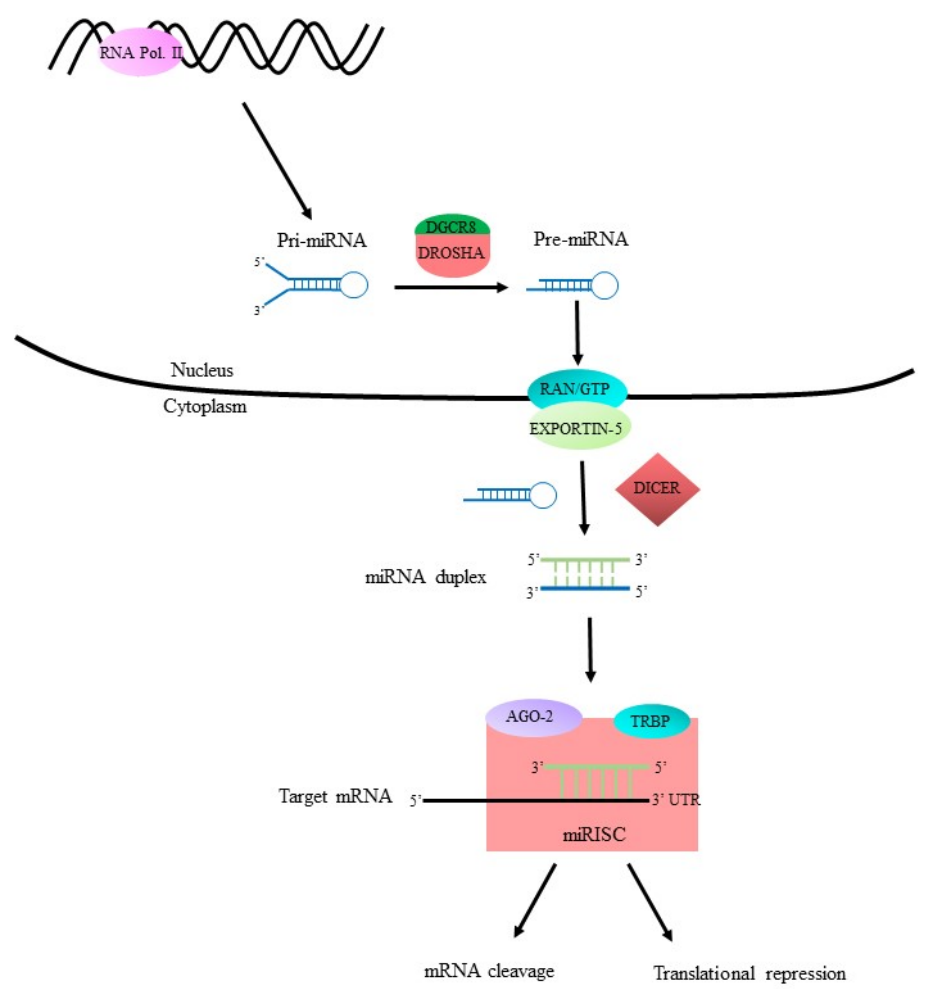
Figure 1. Canonical miRNA biogenesis pathway. RNA polymerase II transcribes DNA of interest into pri-miRNA containing ~80 nucleotides (nts). The Drosha/DGCR8 microprocessing complex cleaves pri-miRNA into pre-miRNA which contains ~65 nts. The Ran-GTP/Exportin-5 complex binds to pre-miRNA and exports it from the nucleus into the cytoplasm. Dicer aids in unwinding and transforming pre-miRNA into an miRNA duplex. The miRNA duplex is then further processed by RISC and Ago2 into mature miRNA containing ~22 nts. Then the miRNA-induced silencing complex miRISC either causes cleavage and degradation or translational repression of its target mRNA.